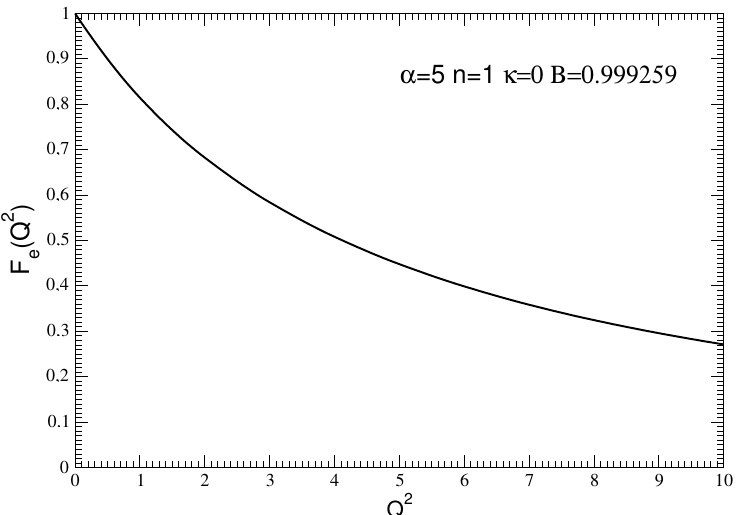
Figure 10. Elastic form factors for the normal state with n = 1, κ = 0—No. 1 of Table 1. (Adapted from [1]).